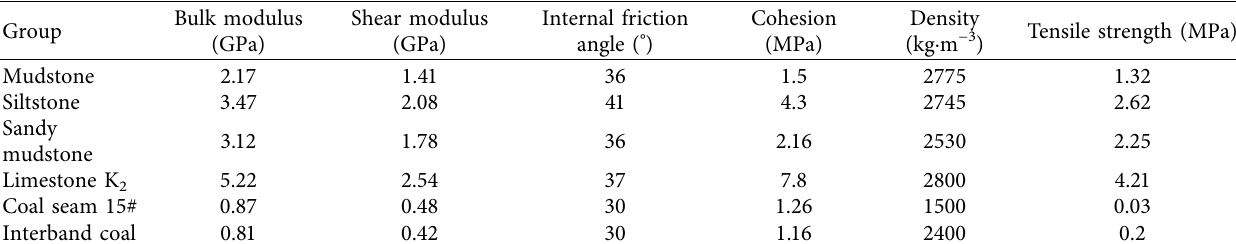
Figure 21: Model dimensions and bedding surfaces. Table 2: Mechanical parameter of